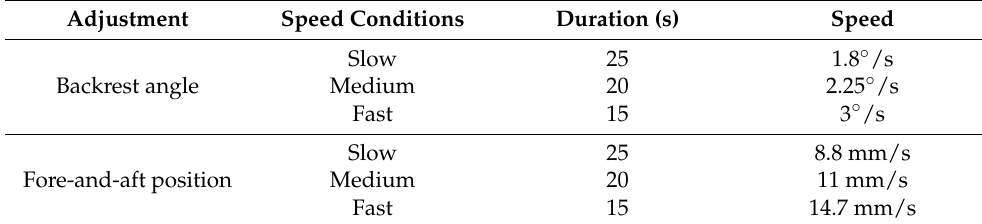
Table 2. The adjustment settings of each speed condition.